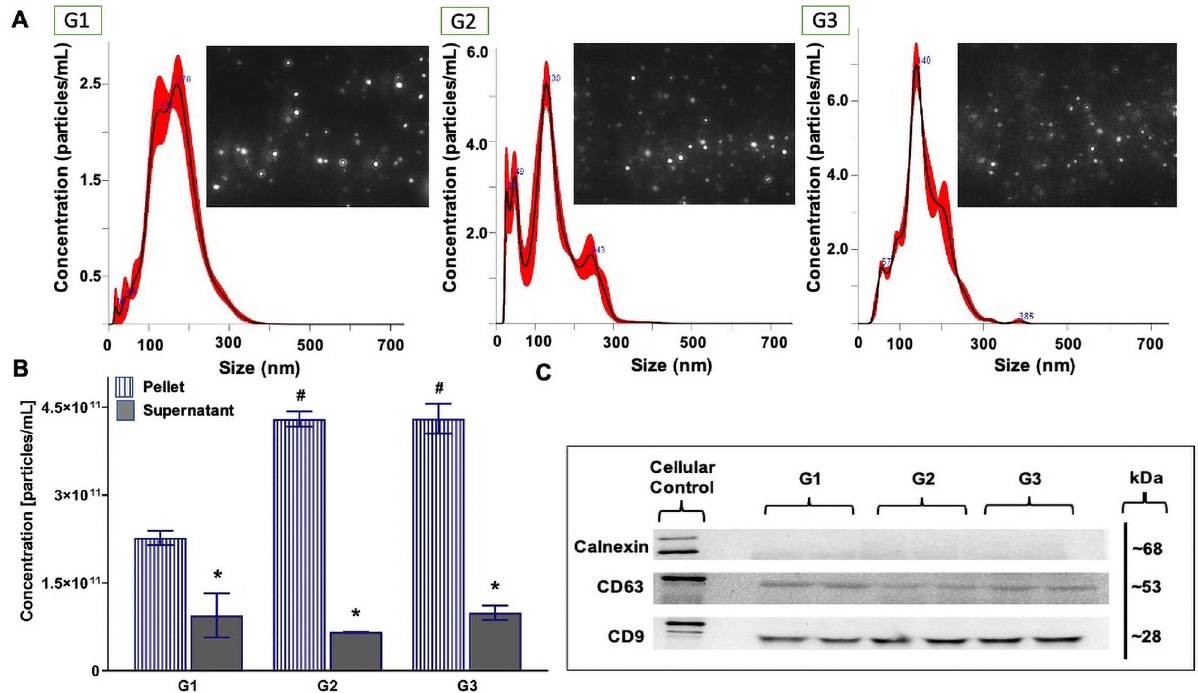
Fig 5. The effect of milk pre-processing prior to long-term storage for bovine milk-derived exosomes isolated via differential ultracentrifugation. Group (G)1: whole milk frozen immediately upon collection and processed post-thaw. G2: Whole milk processed to remove fat globules and cream prior to ultracold storage. G3: Whole milk processed to remove fat globules, cream, milk cells, and casein proteins prior to ultracold storage. Size and distribution profiles of bovine milk-derived exosomes as determined by Nanoparticle Tracking Analysis (NTA) (A). Concentration [particles/ml] of bovine milk-derived exosomes (pellet fraction) (B). Relative protein abundance of two exosome-specific markers (CD9 and CD63) and a cellular protein marker (Calnexin) as determined by western immunoblotting in the pellet fraction (C). Total soluble protein isolated from human microglia (HMC3) cells used to represent cellular protein profiles. Data are mean ± SEM with n = 2 independent trials/group. # Main effect of pre-processing (p � 0.05). � Significant difference in exosome concentration between the pellets and supernatants (p � 0.05).